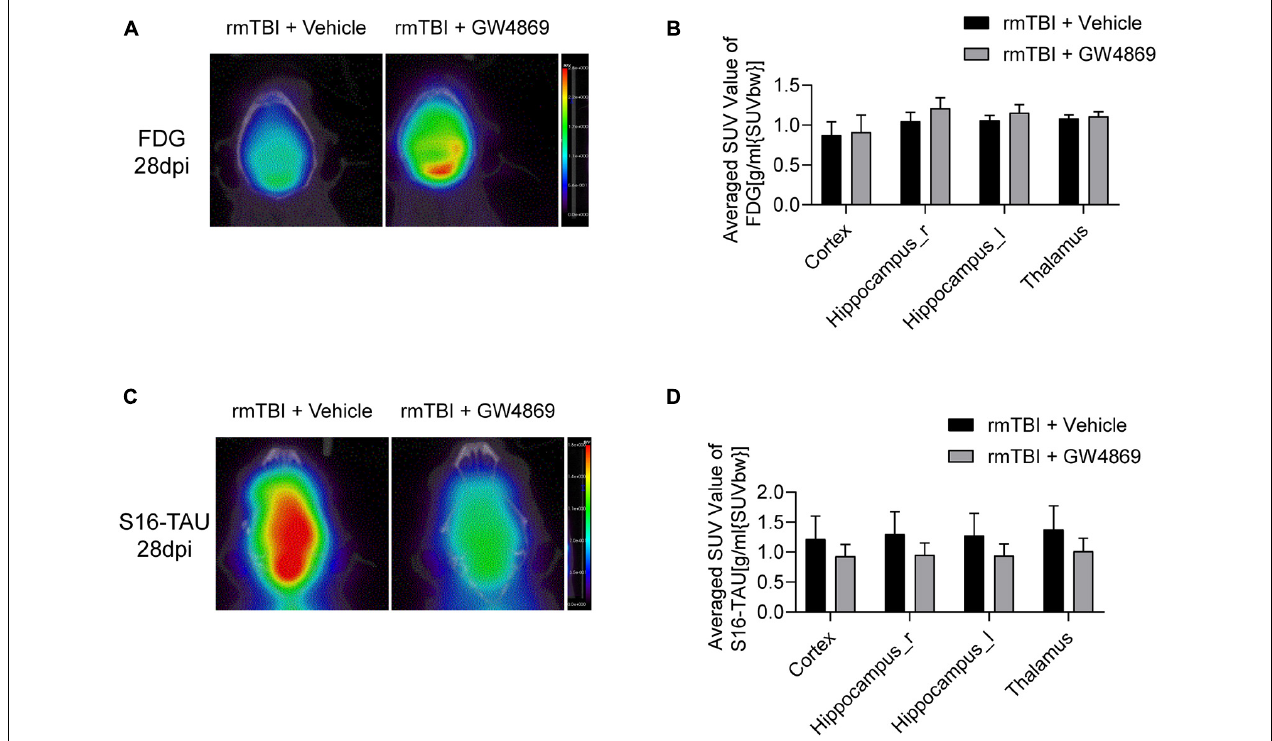
FIGURE 3 | (A) Reconstructed [18F-FDG] PET/CT images of the mice in the rmTBI + Vehicle group and rmTBI + GW4869 group at 28 dpi. (B) Average SUV values of different areas of the brain, including the cortex, both sides of the hippocampus and the thalamus. (B) Bar graph showing that all the brain regions of the mice with rmTBI treated with GW4869 showed much higher glucose metabolism levels. Mean ± SD. n = 5 mice per group. (C) Reconstructed [S16-TAU] PET/CT images at 28 dpi after rmTBI and (D) bar graph showing that the TAU levels of the mice in the rmTBI + GW4869 group were much lower than those of the mice in the rmTBI + Vehicle group. Mean ± SD. n = 5 mice per